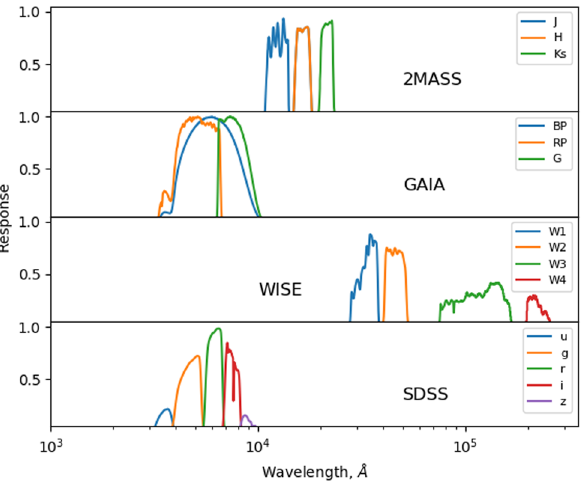
Figure 1: Response curves of photometric